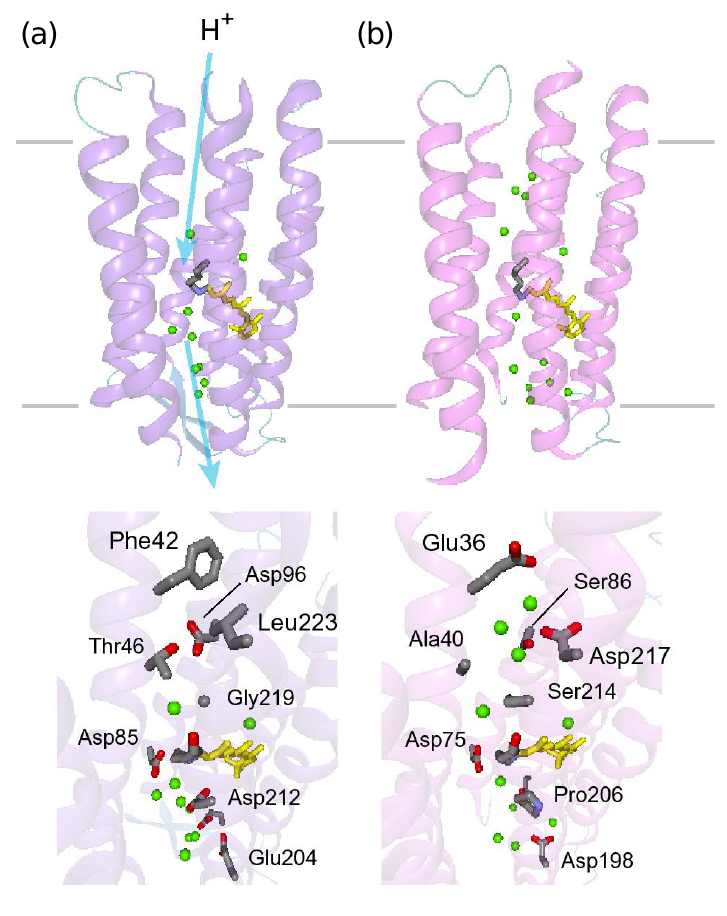
Figure 41. X-ray crystallographic structures of BR [7] (a) and ASR [16] (b). Top and bottom panels represent views from the membrane plane and the cytoplasmic side, respectively. In the top panel, top and bottom regions correspond to the cytoplasmic and extracellular sides, respectively. The retinal chromophore is colored yellow, and green spheres represent internal water